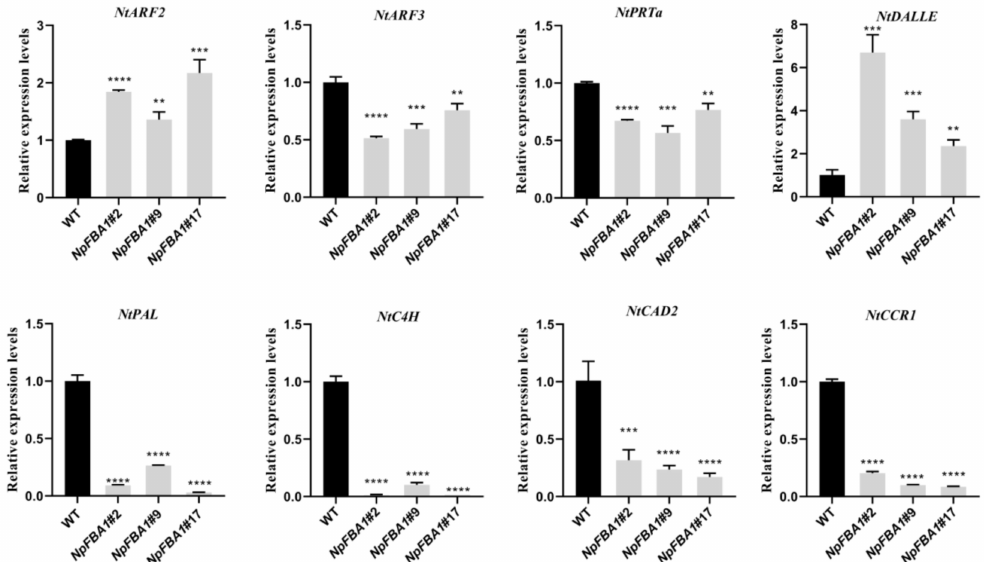
Figure 8. Expression levels of genes associated with growth and development of the WT and transgenic lines. Asterisks indicate significant differences between WT and transgenic plants, ** p < 0.01, *** p < 0.001, **** p < 0.0001, by Student’s t -test, number of samples, n =